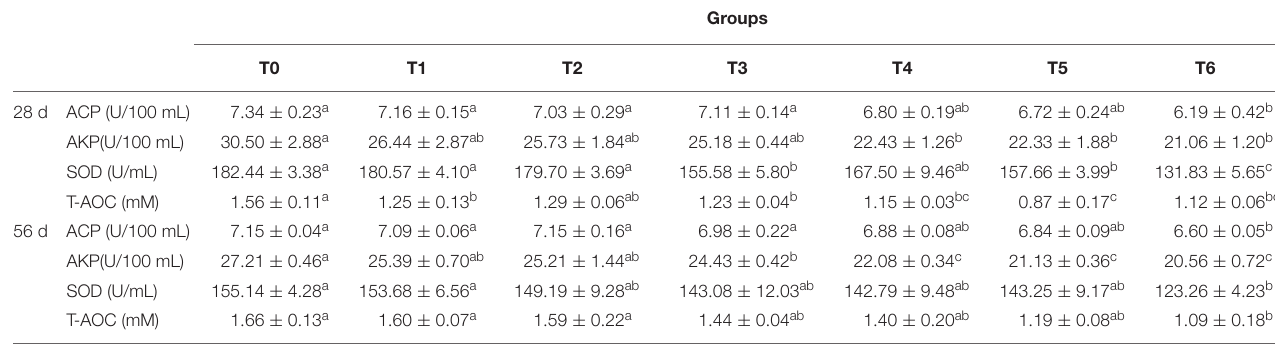
Different characters in the same row data indicate significant differences (P < 0.05). TABLE 3 | Effects of histamine on serum immune parameters of grouper ( Epinephelus coioides ).